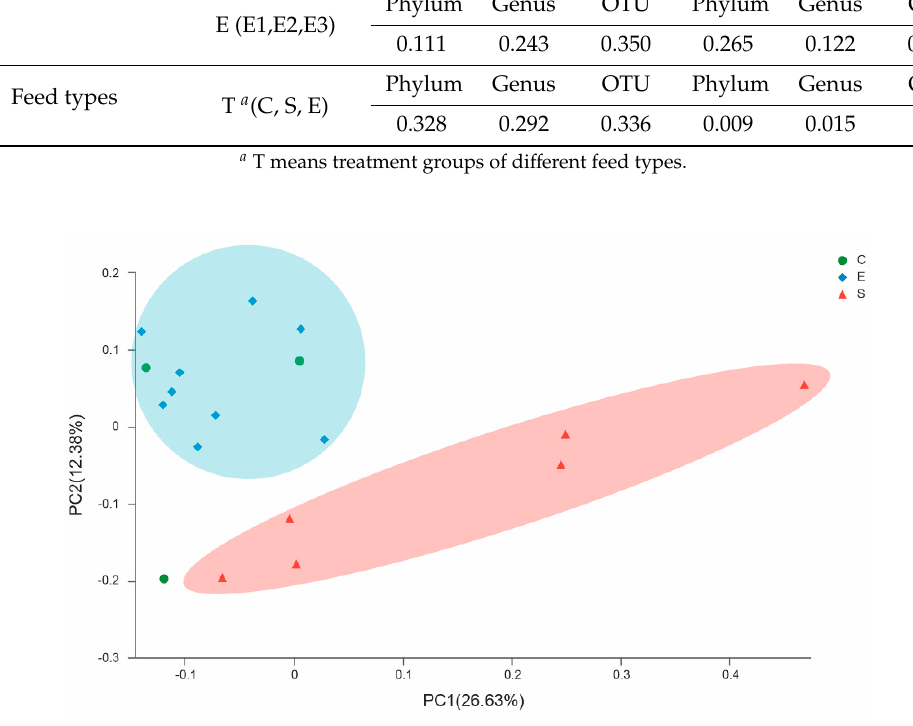
Figure 2. Differences in ruminal bacterial structures among different treatment groups. Principal coordinate analysis (PCoA) was based on the operational taxonomic unit (OTU) data using unweighted and weighted UniFrac distances. Individual samples from C11, C12 and C13 in Group C (green); S11, S12, S13, S21, S22 and S23 in Group S (red); and E11, E12, E13, E21, E22, E23, E31, E32 and E33 in Group E (blue).